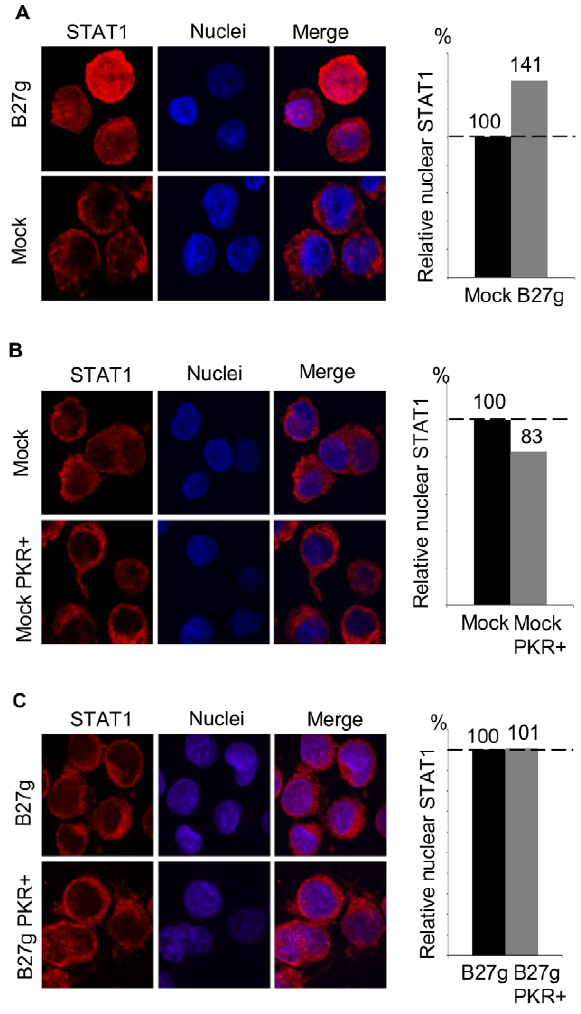
Figure 3. Nuclear localization of STAT-1 and the influence of PKR on STAT-1 localization. A , The confocal microscopy images of the STAT-1 localization in uninfected U937 B27g-expressing cells compared to mock cells. The relative amounts of nuclear STAT-1 of uninfected B27g cells vs. uninfected mock cells (n=136 cells of each) are represented in the diagram. B , The confocal microscopy images of the STAT-1 localization of S. enteritidis -infected U937 mock-transfected cells. In the lower panel, the cells were treated with the PKR inhibitor and all the cells were collected 2 hours after excess bacteria were washed away. The relative amounts of nuclear STAT-1 of S. enteritidis- infected mock vs. mock PKR + (n=88 cells of each) are shown in the diagram. C , The confocal microscopy images of the STAT-1 localization of S. enteritidis -infected U937 B27g-transfected cells. In the lower panel, the cells were treated with the PKR inhibitor and all the cells were collected 2 hours after excess bacteria were washed away. The diagram displays the relative amounts of nuclear STAT-1 of S. enteritidis -infected B27g vs. B27g PKR + (n=73 cells of each). The amount of nuclear STAT-1 was calculated by measuring the amount of red colour (STAT-1) in the defined area of the blue stained nuclei. The relative amounts are weighted averages of 3 independent experiments. (PKR + =cells treated with the PKR inhibitor.)